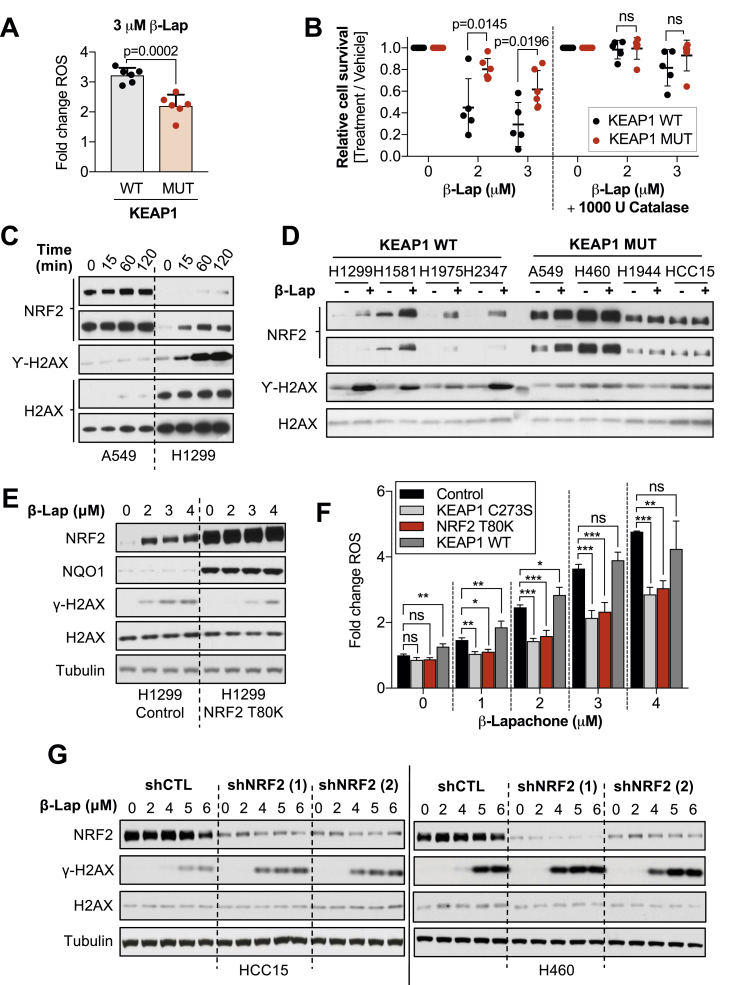
Activation of NRF2 promotes active scavenging of β-lapachone-induced ROS and attenuates DNA damage.(A) A panel of KEAP1 mutant and KEAP1 wild-type NSCLC cell lines were exposed to 3 μM of β-lapachone for 1 h. Relative increase of ROS was measured using the green fluorescent probe CellROX green by flow cytometry. KEAP1WT cells: H1299, H1581, H1975, H2087, H2347, H441. KEAP1MUT cells: A549, H1792, H1944, H2172, H460, HCC15. Data presented as mean ± S.D. (B) Cell survival analyses of NSCLC cell lines exposed to vehicle control, β-lapachone alone or co-treated with 1000 U catalase/well (96-well plate) for 2 h. Surviving cells were stained with crystal violet 48 h after treatment. KEAP1WT cells: H1299, H1581, H441, H2347, H2087. KEAP1MUT cells: A549, H1944, H460, HCC15, H1792, H322. Data presented as mean ± S.D. (C) A549 and H1299 cells, KEAP1 mutant and wild-type respectively, were exposed to 3 μM of β-lapachone for 0, 15, 60 and 120 min, after which cells were collected and protein levels of NRF2, total H2AX (loading control), and the DNA damage marker γ-H2AX (pS139) were assessed by western blotting. (D) Western blot analyses of nuclear extracts of a panel of KEAP1 wild-type (WT) or mutant (MUT) NSCLC cell lines. Cells were treated with 3 μM of β-Lapachone for 2 h. Protein levels of NRF2, total H2AX (loading control), and the DNA damage marker γ-H2AX (pS139) were assessed by western blotting. KEAP1WT cells: H1299, H1581, H1975, H2347. KEAP1MUT cells: A549, H1944, H460, HCC15. (E) DNA damage assessment of H1299 cells (KEAP1 WT) infected with an empty vector (Control) or a virus coding for the expression of NRF2 T80K. Left, cells were exposed to 2, 3 or 4 μM of β-lapachone. Protein levels of NRF2, NQO1, total H2AX (loading control), Tubulin (loading control) and the DNA damage marker γ-H2AX (pS139) were assessed by western blotting. See Supplementary Fig. 2A. (F) H1299 cells (KEAP1 WT) were infected with an empty vector (Control) or a virus coding for the expression of NRF2 T80K, KEAP1 wild-type or KEAP1 C273S. Cells were exposed to 1–4 μM of β-lapachone for 1 h and resulting fluorescent signal of the probe CellROX green was measured by flow cytometry. P-values were calculated using one-way ANOVA statistical test followed by the multiple comparison Dunnett's test to compare between treatment groups. *P < 0.05, **P < 0.01, ***P < 0.001, ****P < 0.0001. Data presented as mean ± S.D. (G) H460 and HCC15 cells (KEAP1 MUT) infected with virus coding for shRNAs against NRF2 (shNRF2) or an shRNA control were treated with the indicated concentration of β-lapachone for 2 h, after which protein levels of NRF2, total H2AX (loading control), Tubulin (loading control) and the DNA damage marker γ-H2AX (pS139) were assessed by western blotting. (For interpretation of the references to colour in this figure legend, the reader is referred to the Web version of this article.)